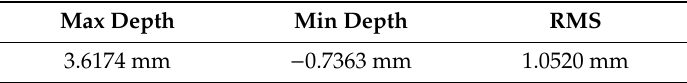
Figure 22. The specific places on the practical damaged rail surface with scratch-depth larger than 1 mm . Table 8. The analysis result of the artificial damaged rail.